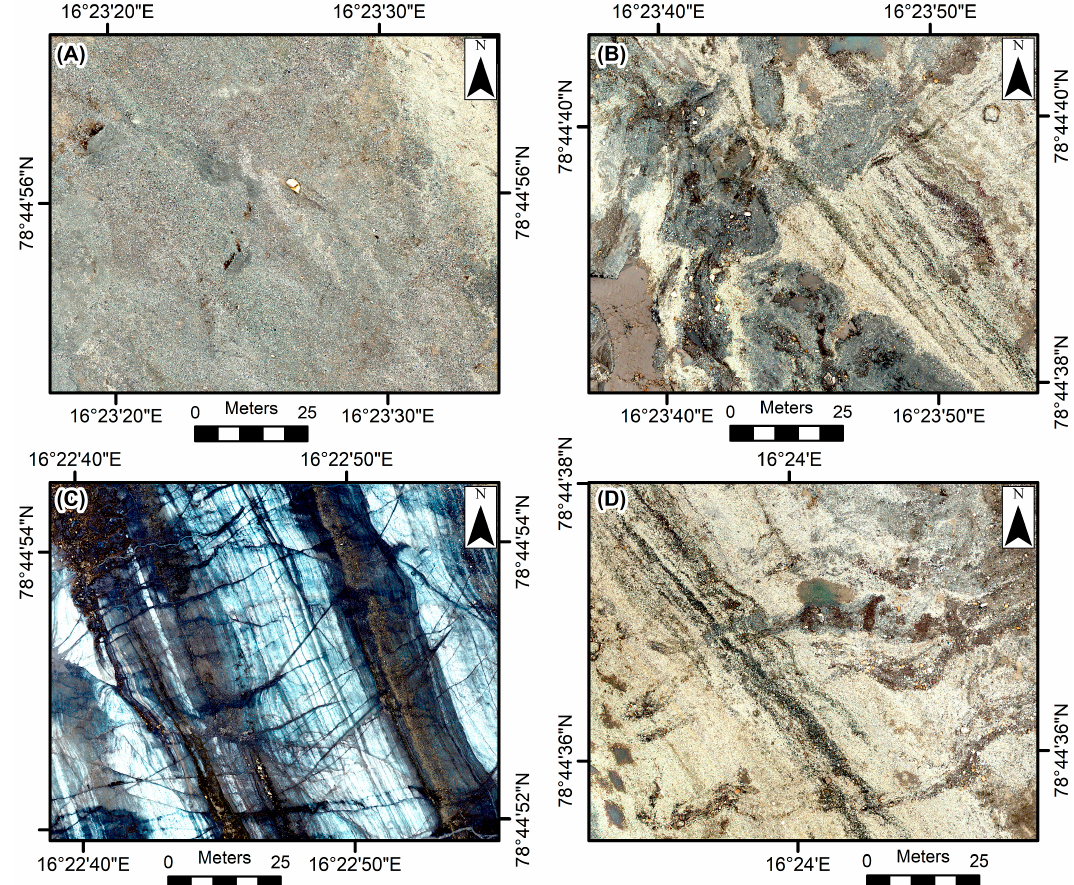
Figure 5. Samples of full resolution (1.9 cm GSD) orthomosaic showing the same locations as in Figure 4. Foreland of Hørbyebreen, Svalbard. Note, that comparing to the visualization of hillshade model (Figure 4), some elements are better visible, whereas others are harder to recognize; e.g., ( A ) Flutes are hard to identify, but the boulders are clearly visible; ( B , D ) It is hard to recognize transverse ridges and to assess their height; however, it is much easier to differentiate between transverse ridges and debris flow stripes, due to the difference in the color of the debris; ( C ) Crevasse traces and longitudinal foliations are clearly visible; in addition longitudinal debris stripes are also easy to identify.